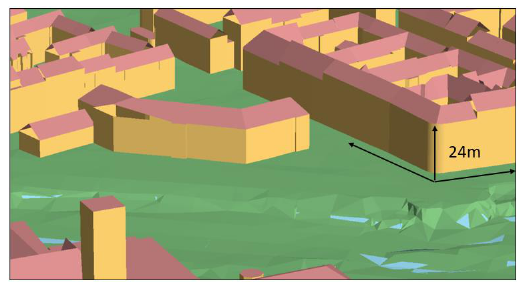
Figure 8 : CityGML model representing a future urban densification scenario (buildings are extended